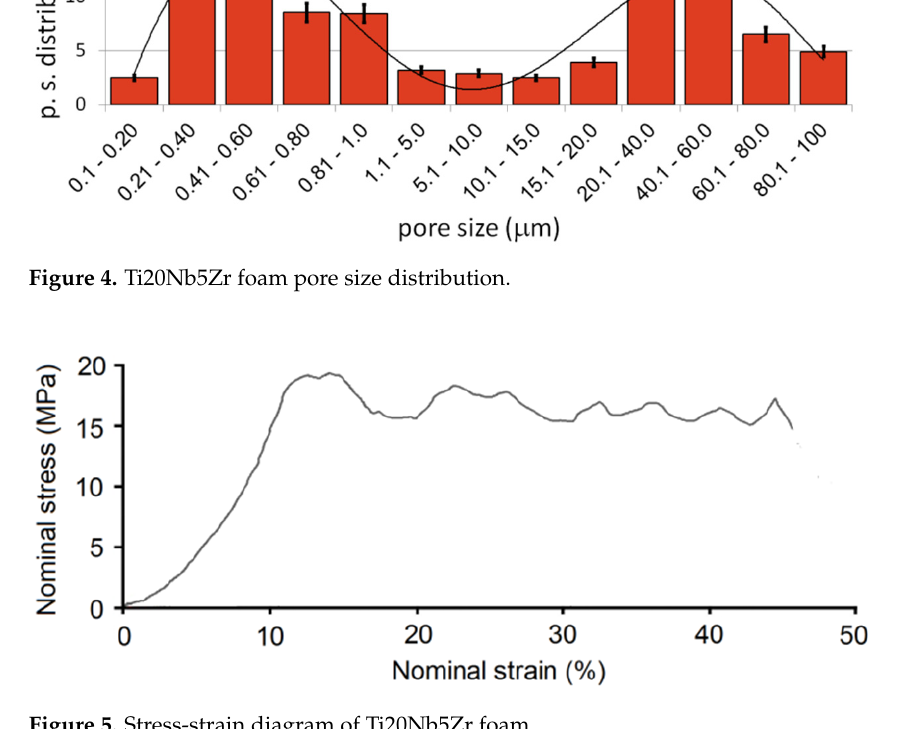
Figure 5. Stress-strain diagram of Ti20Nb5Zr foam.